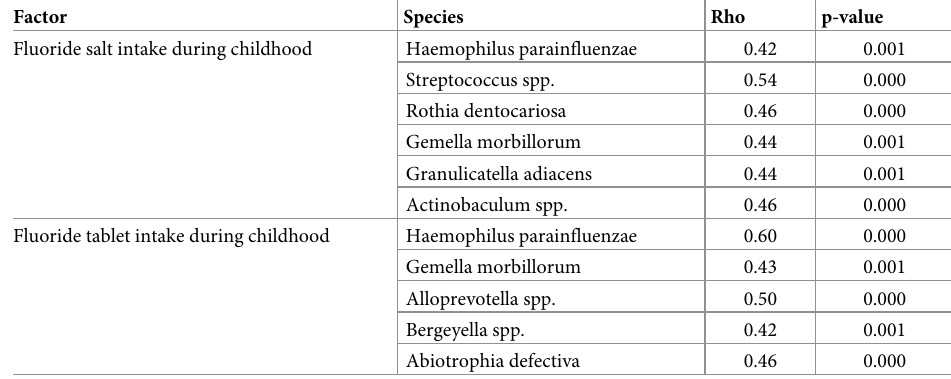
Table 3. Correlation network